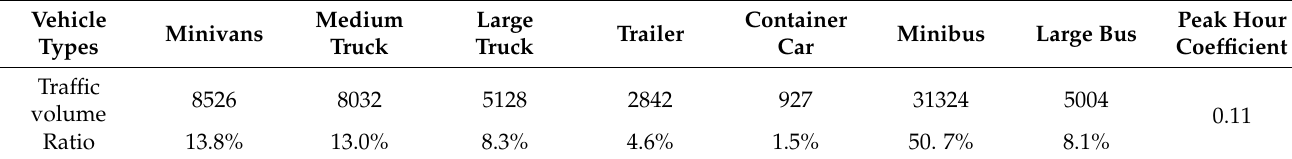
Table 5. Results of estimated traffic volume in 2023.